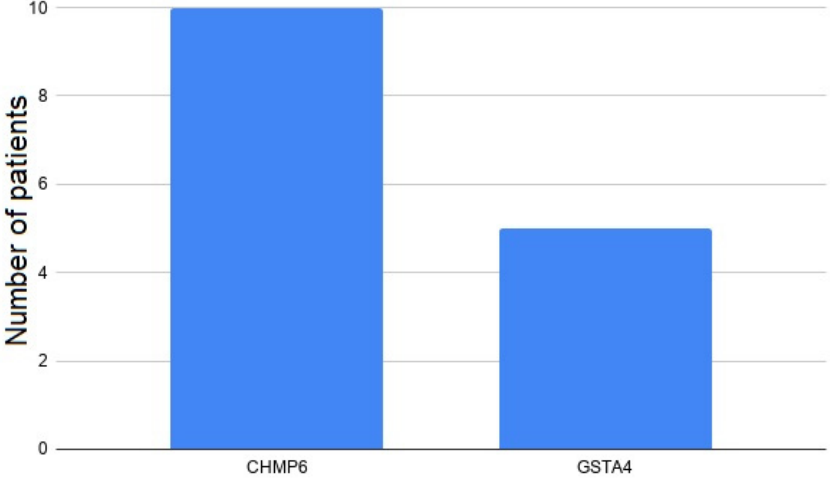
Figure 3. Frequency of highly dysfunctional variants within genes identified in the burden test.